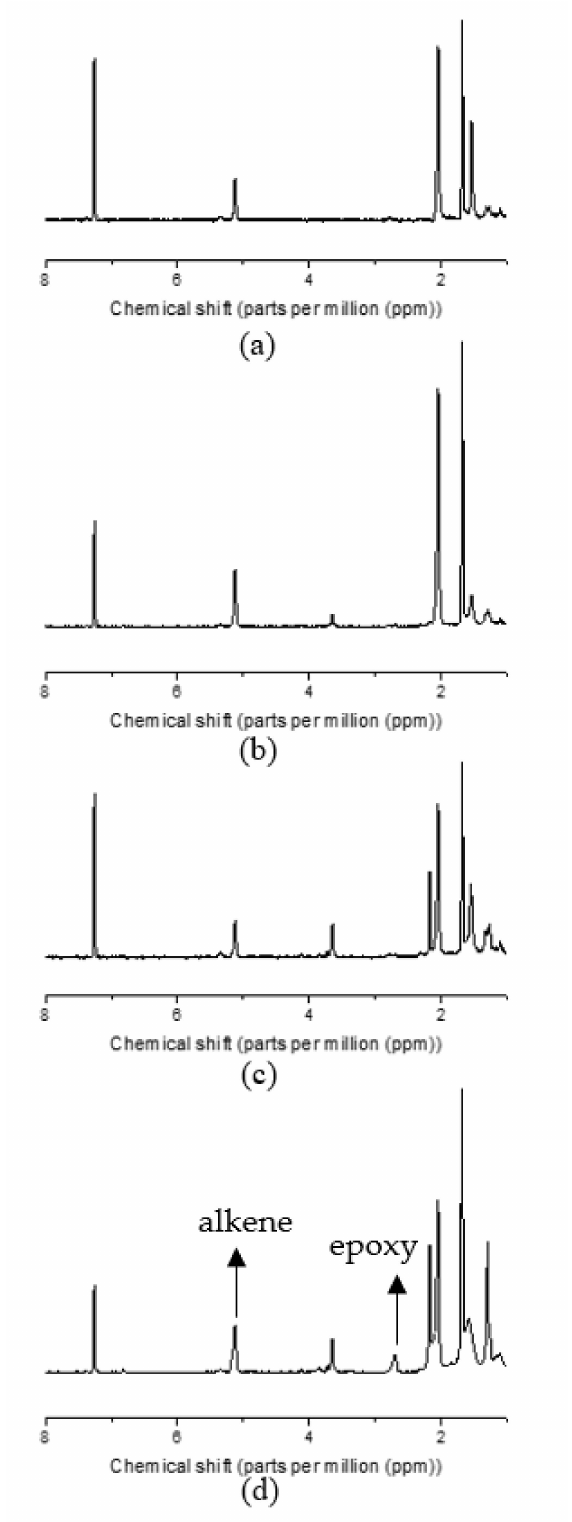
Figure 1. NMR spectra of guayule natural rubber (GNR) and epoxidized guayule natural rub- ber (EGNR): ( a ) GNR; ( b ) EGNR (mole ratio = 0.15); ( c ) EGNR (mole ratio = 0.30); ( d ) EGNR (mole ratio =